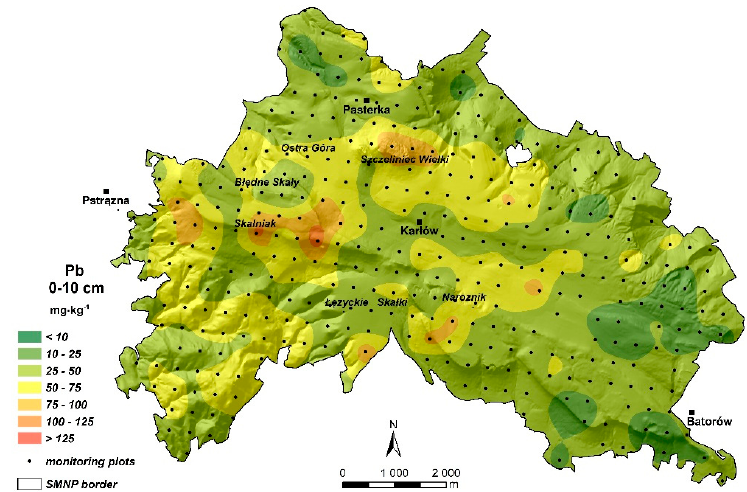
Figure 5. Prediction map of the spatial Pb distribution, developed by simple kriging for the reduced monitoring network (RMNet).